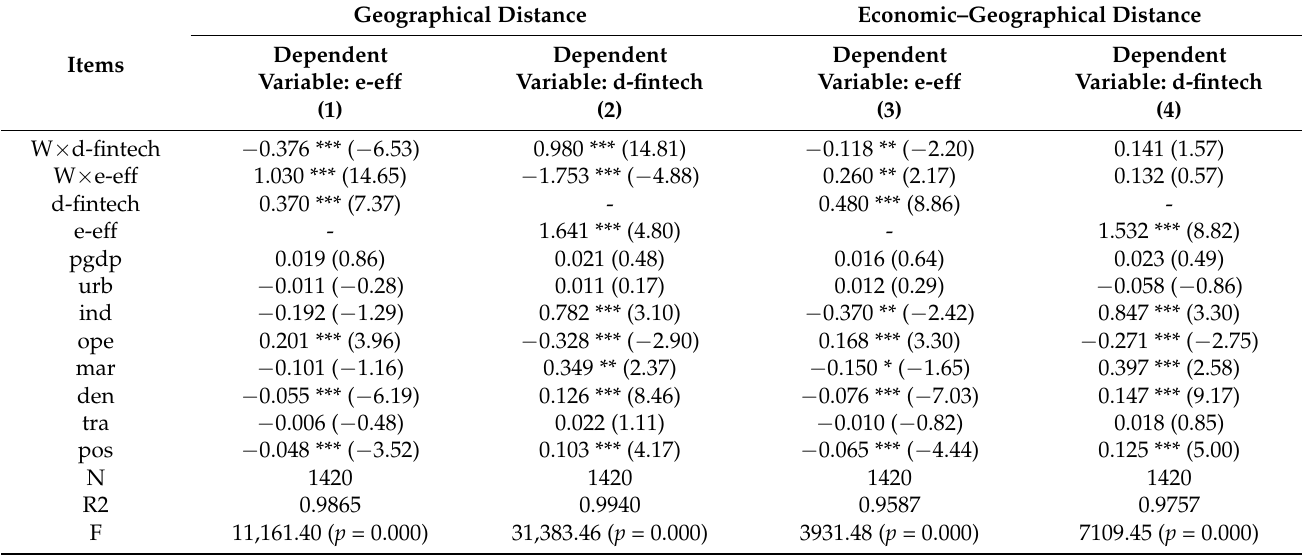
Table 11. Period estimation results of GS3SLS (2008–2012).